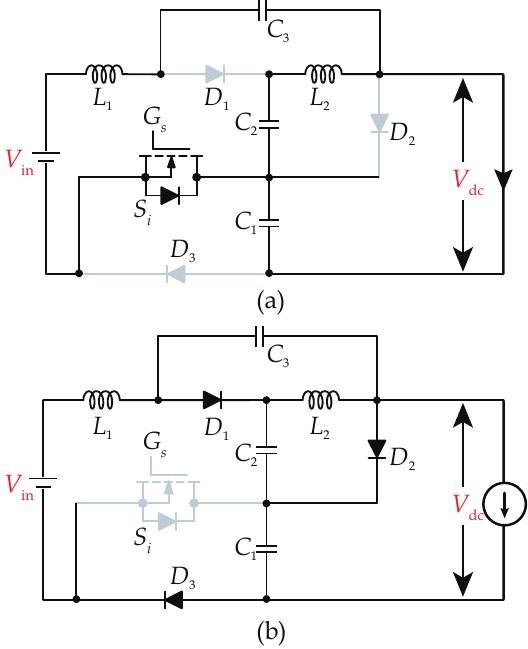
Figure 5. Operation principles of the proposed S-qZSI: ( a ) equivalent circuit during the shoot-through state, and ( b ) equivalent circuit during the non-shoot-through